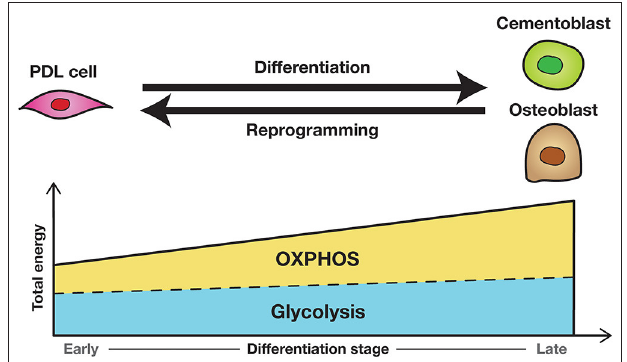
FIGURE 2 | The hypothesis of dynamic metabolic preferences during osteogenic differentiation and reprogramming of PDL cells. OXPHOS is largely used at the early stage of differentiation because osteogenic differentiation requires tremendous energy. Undifferentiated PDL cells may alter their metabolic profiles from glycolysis to OXPHOS toward their differentiation; the osteogenic cells may do vice versa toward their reprogramming. PDL, periodontal ligament; OXPHOS, oxygen